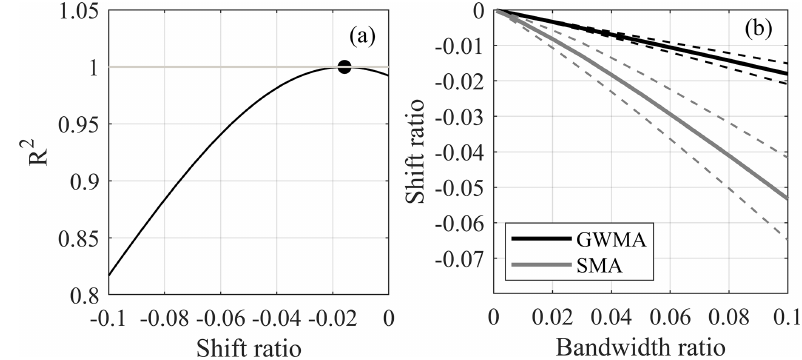
Figure 15. (a) R 2 values for scenario 7 with filtered and shifted results at an n/t value of 0.01 and bandwidth ratio of 0.04 and (b) shift ratio at peak R 2 for all scenarios and n/t ratios, with the mean (solid line) bounded by 1 standard deviation (dashed lines)